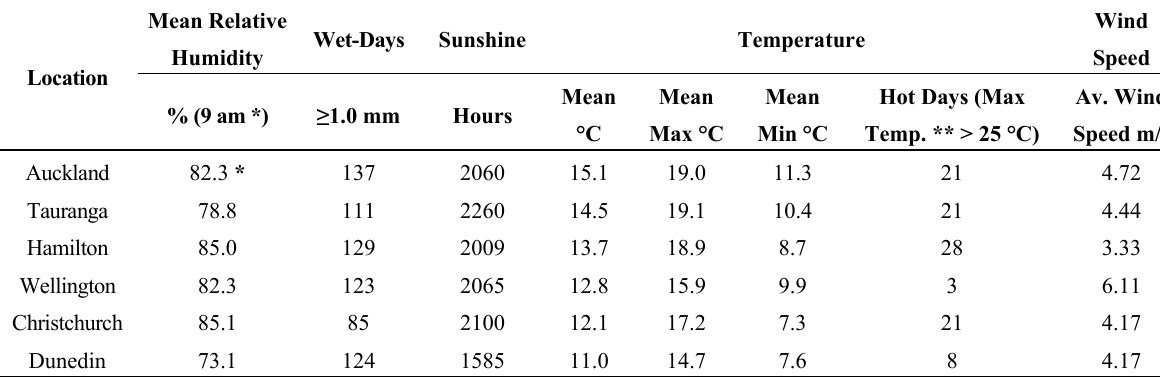
Table 1. Summary of climate information for the six main City Centres in New Zealand ( * Average Relative Humidity (RH) levels were taken at 9 am, hence these figures vary approximately if combined with afternoon RH levels—For the case of Auckland, this would decrease annual RH approximately to 76%. ** Annual count of “hot days” where temperatures exceeded 25 °C—values presented are annual averages since mid-twentieth century. Wet-days, sunshine, temperature, wind speed, and average relative humidity data are mean values from the 1981–2010 period). Adapted with permission from NIWA